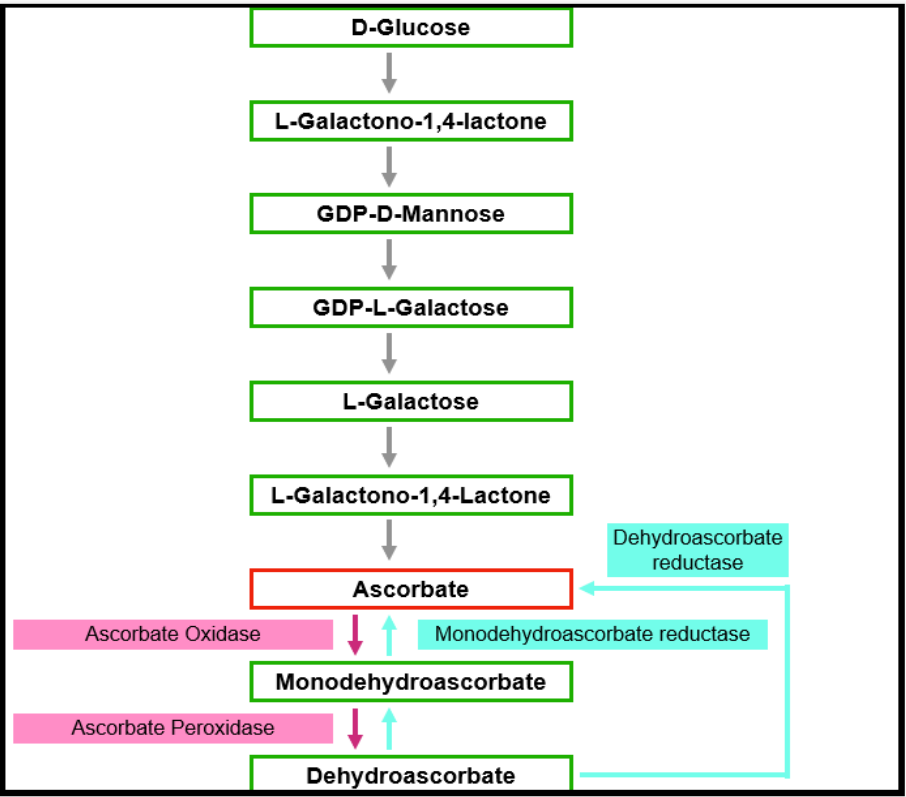
Figure 4. Outline of the pathway of ascorbate biosynthesis in plants. Ascorbate is a major antioxidant found in all plant tissues. The pathway of biosynthesis may vary due to the availability of precursors.